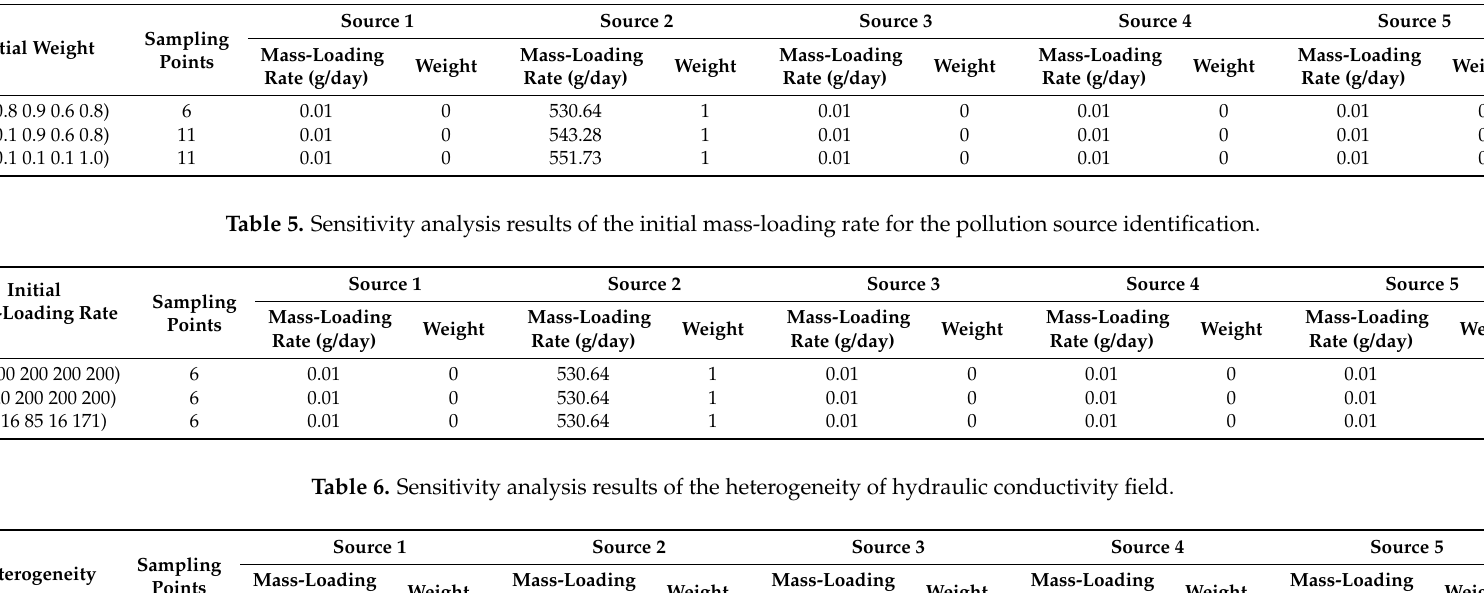
Table 4. Sensitivity analysis results of the initial weight for pollution source identification.